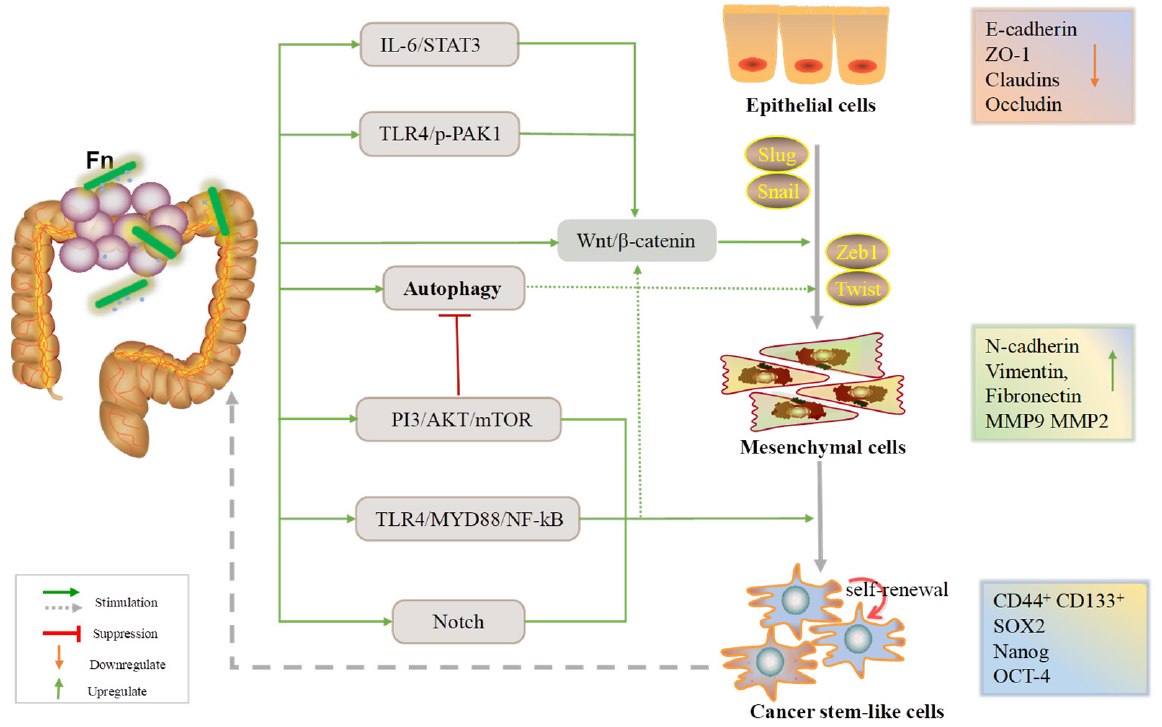
Figure 1. An overview of the EMT process during which Fn is involved in the development of